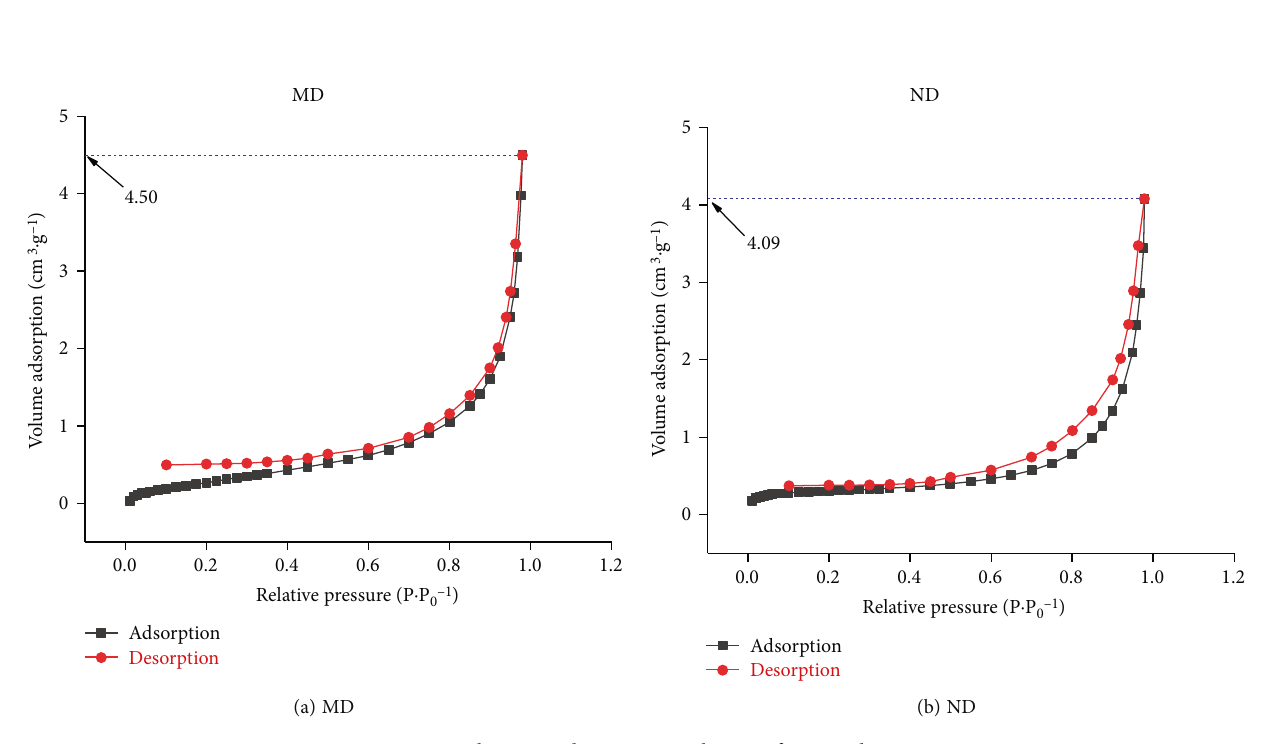
Figure 5: Adsorption-desorption isotherms of MD and ND.